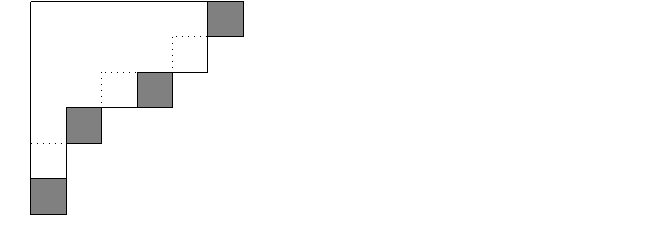
Figure 2 . An example of Young diagram (cid:21) and boxes in A ( (cid:21) ) (shaded) and in R ( (cid:21) ) (dotted). (Boxes in A ( (cid:21) ) do not belong to (cid:21) , and R ( (cid:21) ) (cid:26) (cid:21) . We always have j A ( (cid:21) ) j (cid:0) j R ( (cid:21) ) j = 1.) Notation related to Young